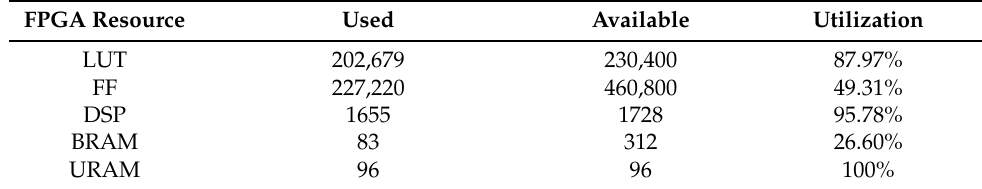
Table 3. FPGA Resource utilization for the CNN accelerator. FPGA